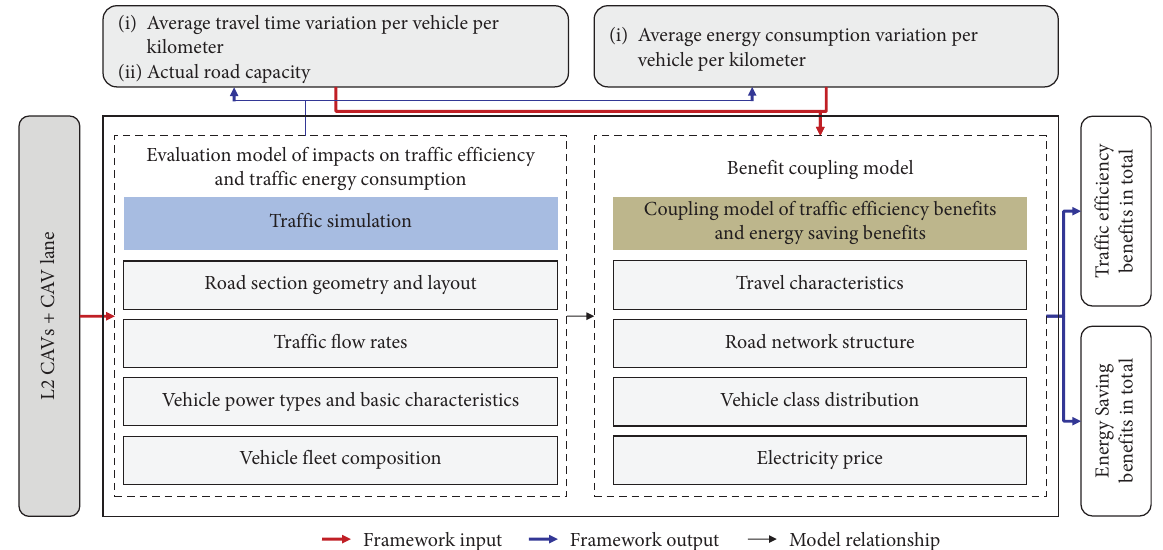
Figure 1: Te evaluation framework of CAV’s trafc benefts.